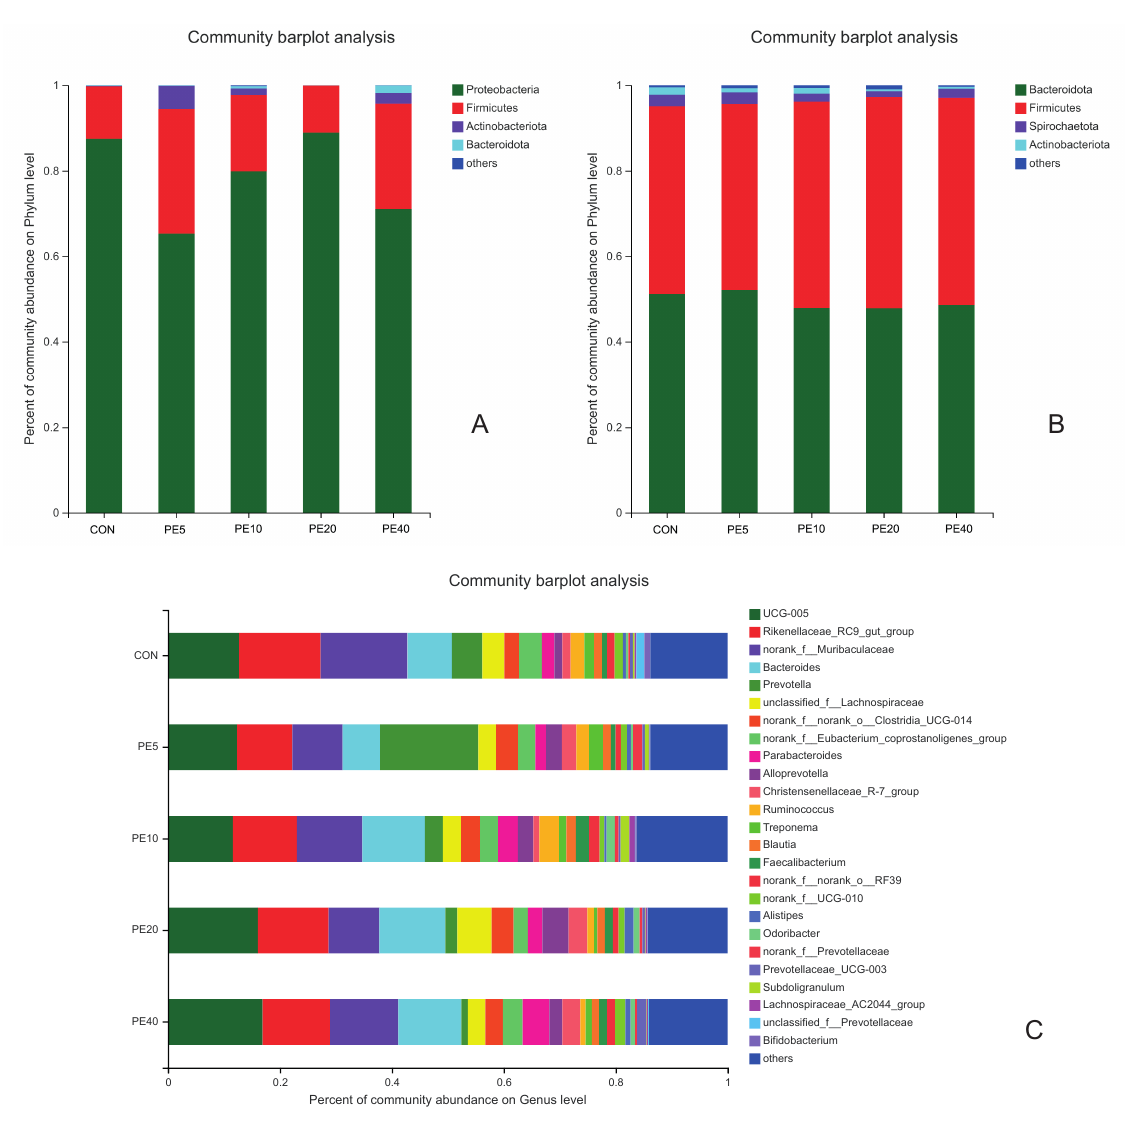
Figure 3. Relative abundance of fecal bacterial community of calves supplemented with Amla ( Phyllanthus emblica ) whole-fruit powder at ( A ) 2 days of age on phylum level; ( B ) 75 days of age on phylum level; ( C ) 75 days of age on genus level. CON, PE5, PE10, PE20, and PE40 indicate control (0), 5, 10, 20, and 40 g/d/head supplementation of Amla fruit powder,